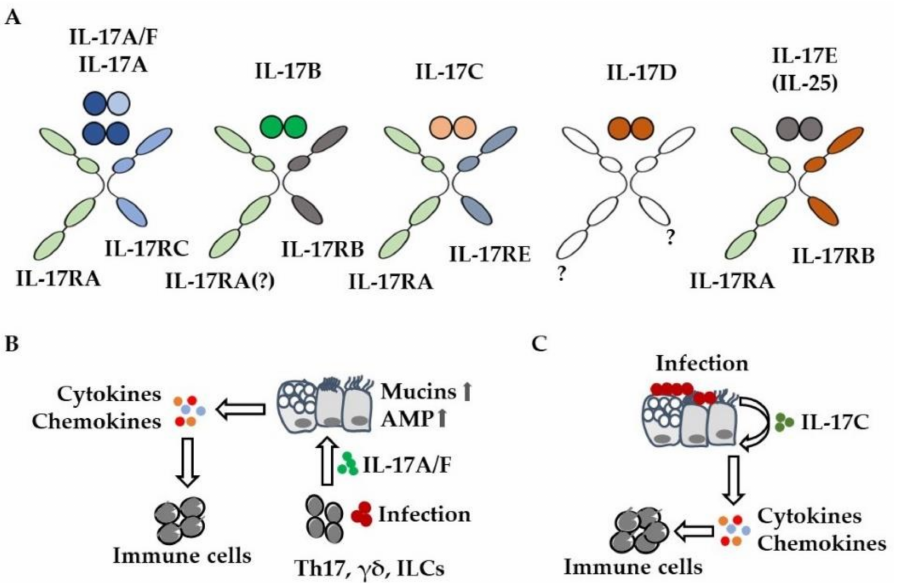
Figure 1. IL-17 cytokines mediate the recruitment of immune cells. ( A ) IL-17 cytokine and receptor family. To which receptors (?) IL-17B and IL-17D bind remains to be elucidated. ( B ) Infection results in the release of IL-17A from immune cells ( γδ T, innate lymphoid (ILC), Th17 cells). IL-17A activates lung epithelial cells, resulting in enhanced chemokine-mediated recruitment of immune cells (e.g., neutrophils) and enhanced expression ( ) of mucins and antimicrobial peptides (AMP). ( C ) Bacteria and viruses induce the expression of IL-17C in lung epithelial cells. IL-17C enhances the expression of cytokines and chemokines in an autocrine manner, resulting in increased pulmonary